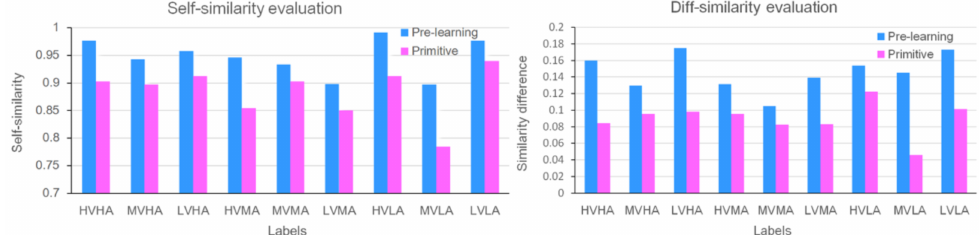
Figure 7. Similarity evaluation of eigenvectors between stacked sparse auto-encoder (SSAE0 pre-learning and original under different emotion labels. Left, self-similarity evaluation (concentration); right, evaluation of diff-similarity (separability).